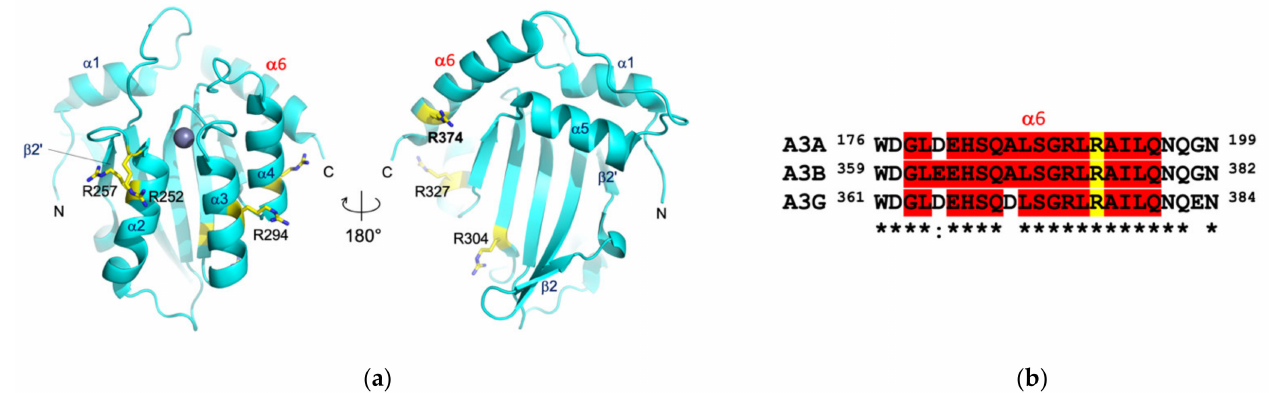
Figure 5. A3Bctd structure and the C-terminal α 6 sequences of Z1-type deaminases. ( a ) Crystal structure of A3Bctd [8], with the locations of the surface-exposed Arg residues mutated in this study and the C-terminal α 6 helix highlighted. ( b ) Alignment of α 6 sequences from A3A, A3Bctd, and A3Gctd. The conserved Arg residue (Arg374 in A3B) is in